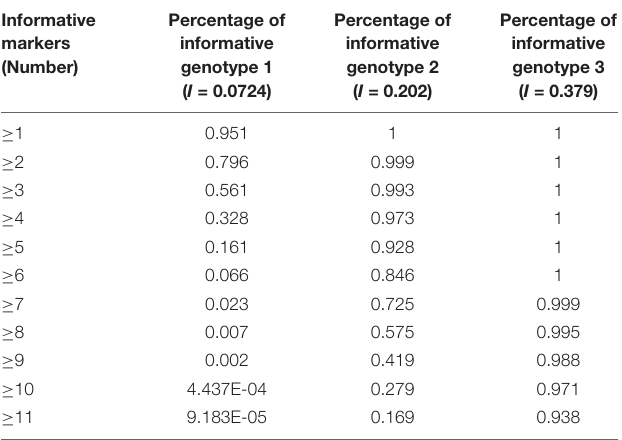
TABLE 4 | Expected estimate for occurrence of informative markers using 40 SNP-STR markers.